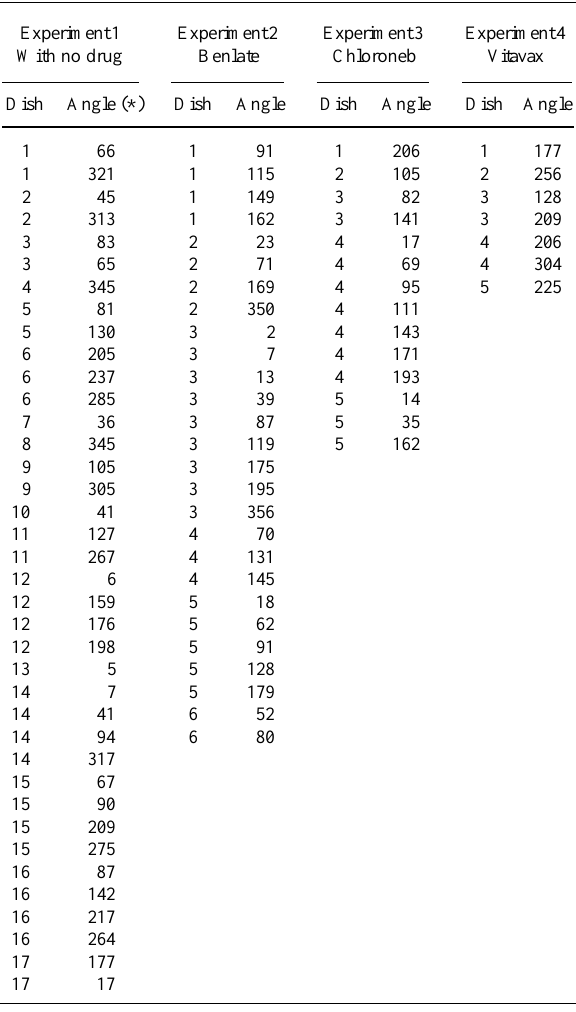
Table I - Direction of sector appearance in strain A of Aspergillus nidulans